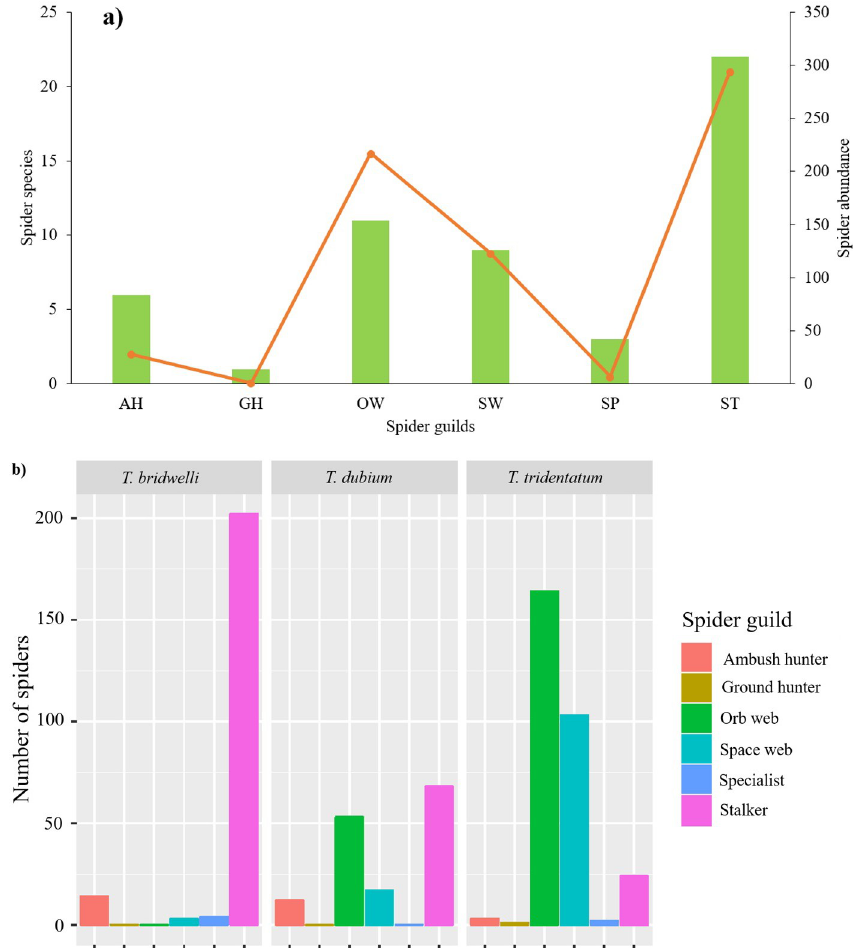
Fig 4. Captured spider guilds. a) Total species richness and abundance per spider guild. Bars represent the richness (q = 0) and the line the abundance (right axis). b) Abundance of spider guilds in the diet of each wasp species. AH = ambush hunter, OW = orb web, SW = spatial web, ST = stalker, GH = ground hunter, SP = specialist.